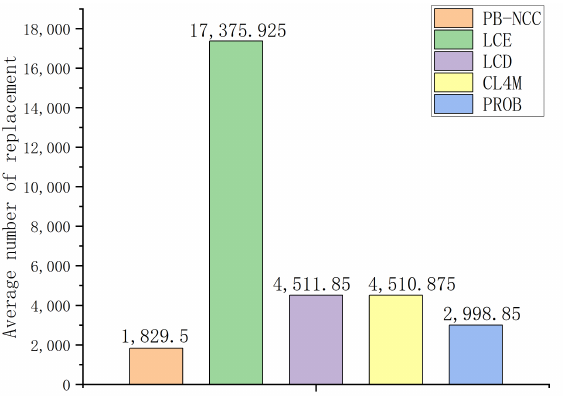
Figure 6. Performance of different cache strategies in different node